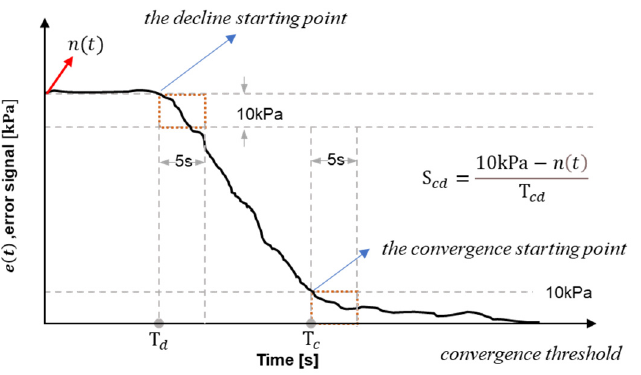
Figure 6. Definition points of convergence condition aiming at PID control algorithm observing error amount.